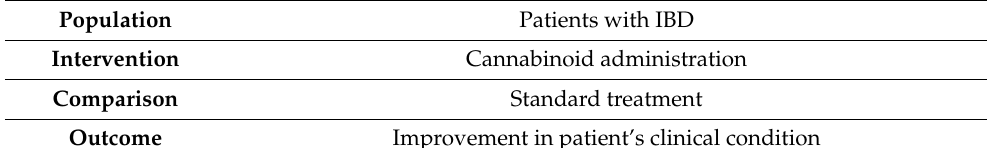
Population Patients with IBD